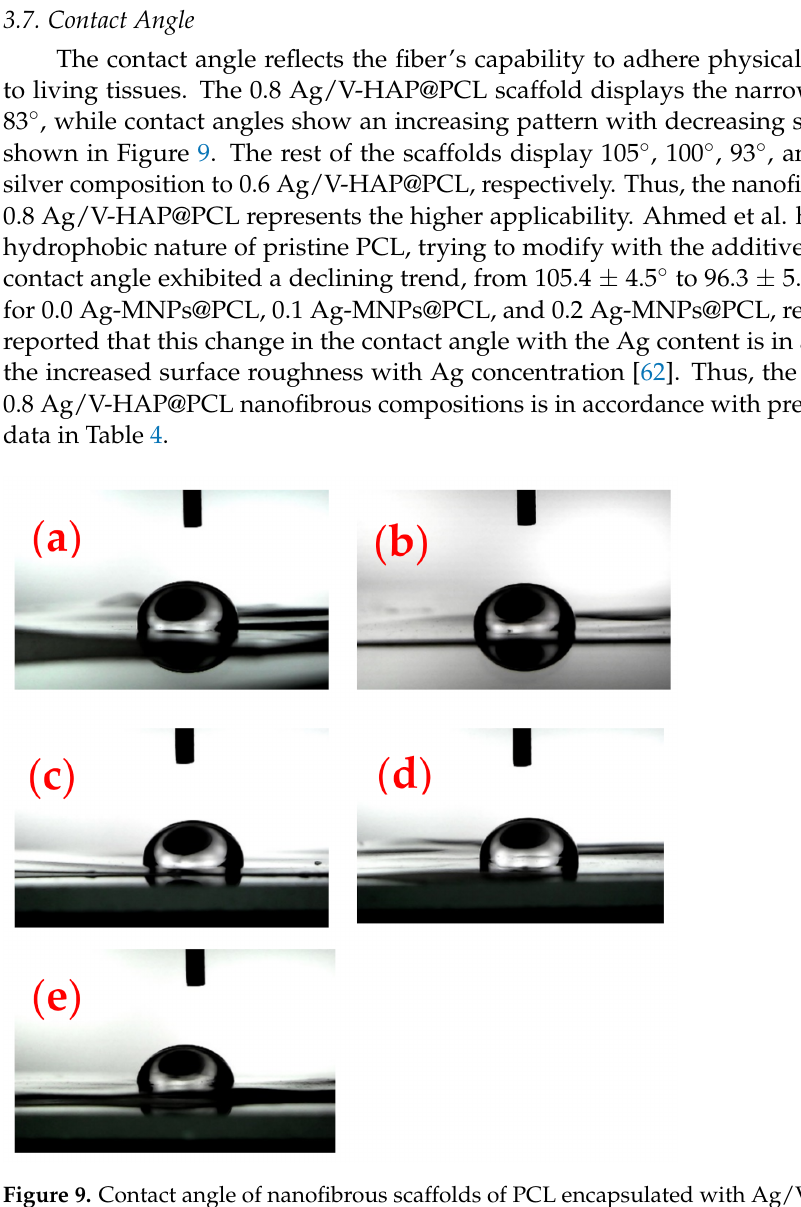
Figure 9. Contact angle of nanofibrous scaffolds of PCL encapsulated with Ag/V-HAP at different additions of Ag ions; ( a ) 0.0 Ag/V-HAP@PCL, ( b ) 0.2 Ag/V-HAP@PCL, ( c ) 0.4 Ag/V-HAP@PCL, ( d ) 0.6 Ag/V-HAP@PCL, ( e ) 0.8